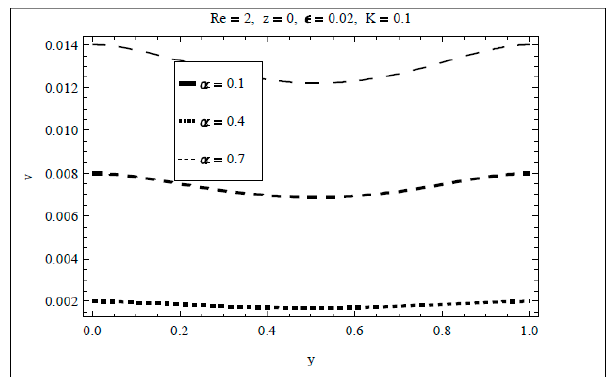
ff ect of α on cross-flow velocity v along y . Figure 5. Effect of α on cross-flow velocity v along y . Figure 5. E